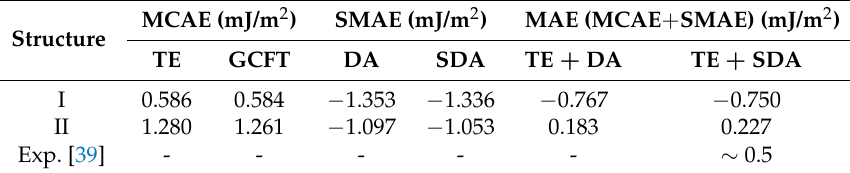
Table 1. The magnetic anisotropy energy (MAE) from magnetocrystalline anisotropy energy (MCAE) and shape magnetic anisotropy energy (SMAE) for structure-I and structure-II and the comparison with the available experimental data. The MCAE is calculated based on TE and grand canonical force theorem (GCFT). The SMAE is evaluated from discrete approach (DA) and spin density approach (SDA).